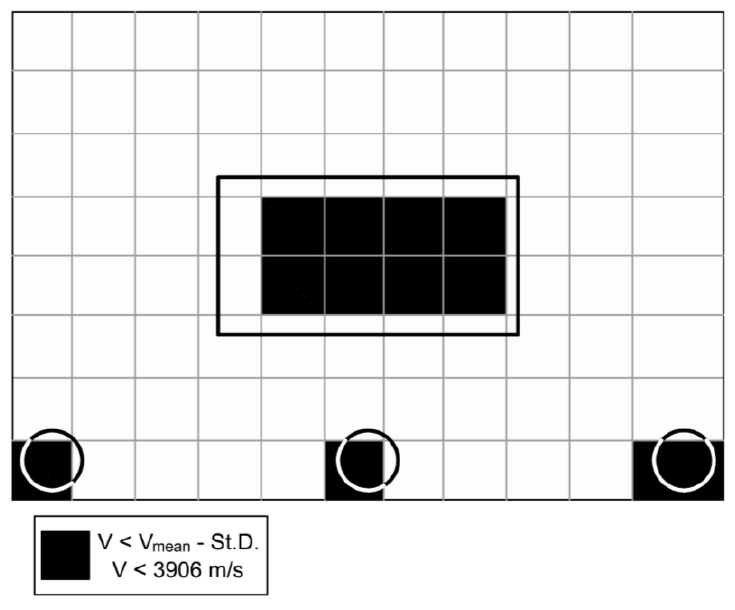
Figure 10. Map 8: Grid C. Defective areas.